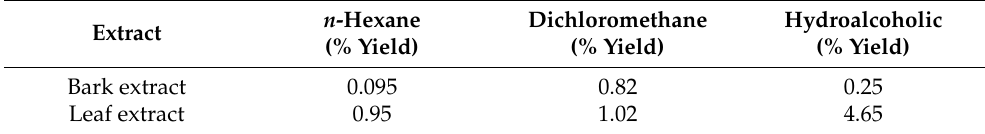
Table 1. Percentages obtained from Inga jinicuil extracts.